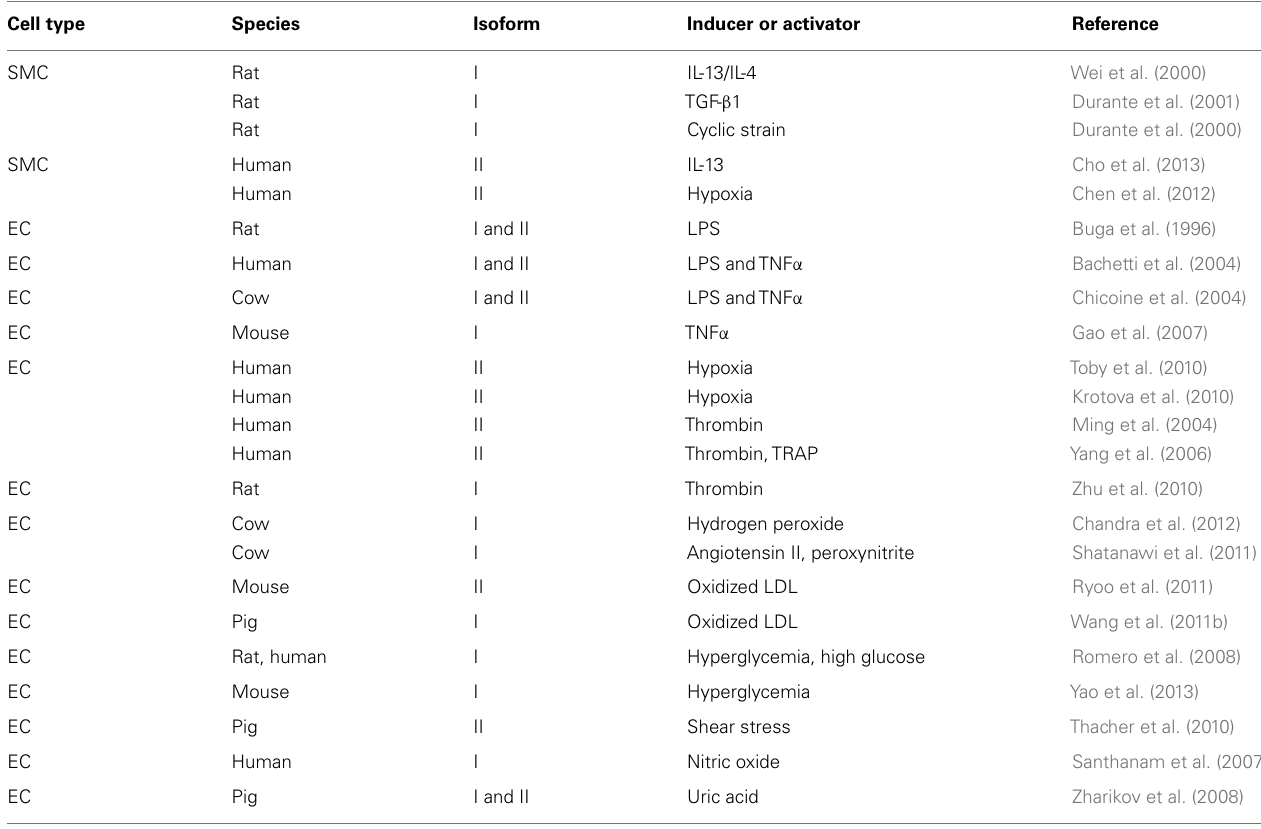
Table 1 | Regulation of cellular arginase expression and